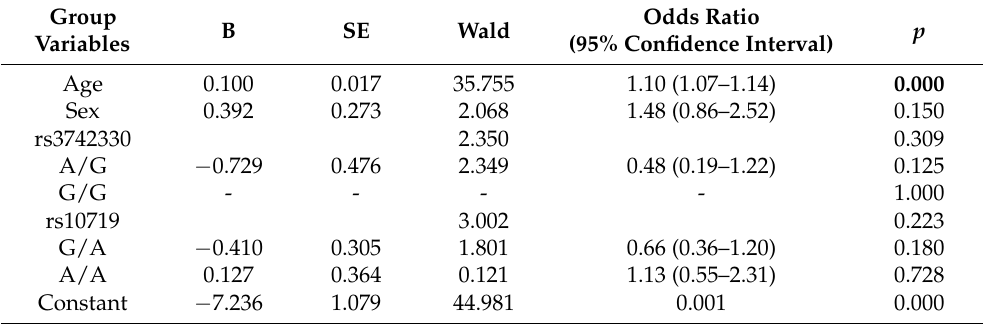
Table 6. Binary logistic regression analysis to determine the effect of age, sex, and